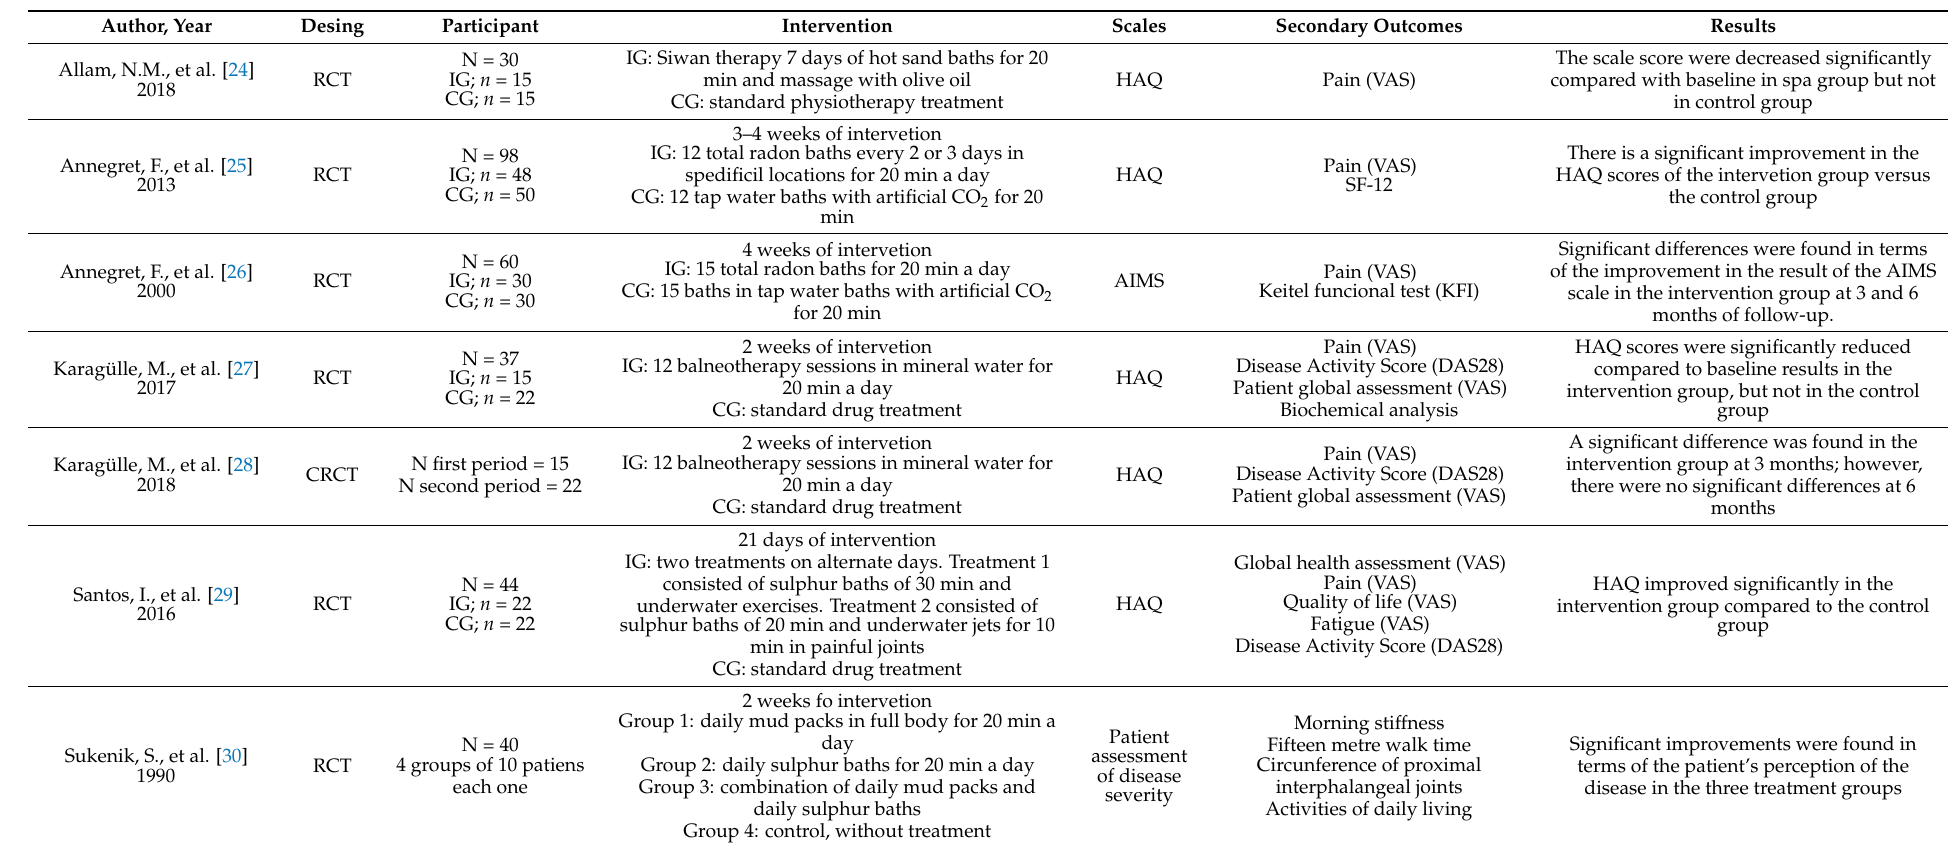
Table 1. Main characteristic of selected